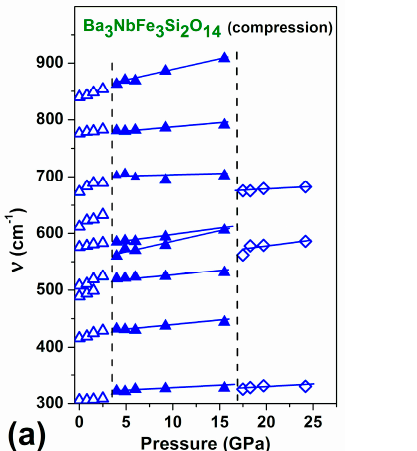
Figure 5. (Colour online) Pressure behavior of Raman peak positions in Ba 3 NbFe 3 Si 2 O 14 at compression ( a ) and decompression ( b ). Dashed lines correspond to the structural transitions observed in XRD and Mössbauer experiments. Solid lines are guides to the eye.